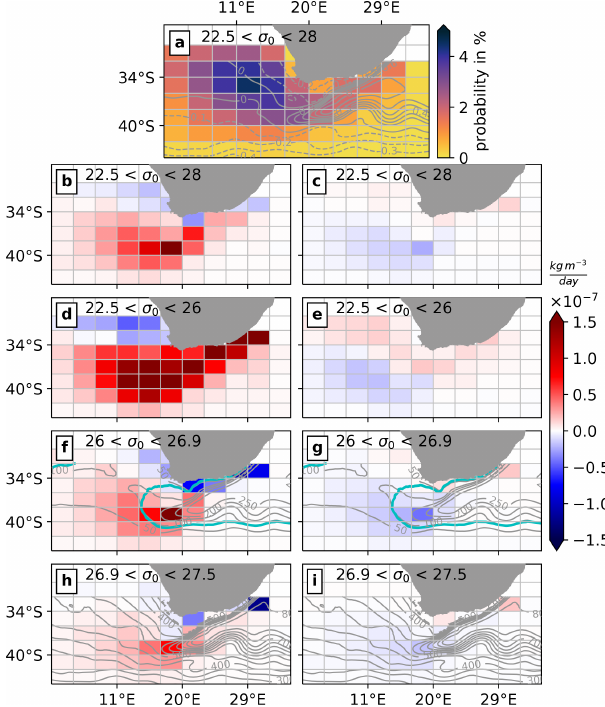
Figure 7. Pathways and horizontal distribution of the density changes of Agulhas leakage for experiment P: (a) relative transport- weighted probability in percent of all Agulhas leakage waters (con- sidering all Agulhas leakage particles per bin at each time step). Contour lines show the mean (1958–2014) sea surface height (in m). Density changes due to the (b, d, f, h) thermal and (c, e, g, i) haline effect for (b, c) all water masses, (d, e) upper waters (22 . 5 < σ 0 < 26), (f, g) central waters (26 < σ 0 < 26 . 9) and (h, i) AAIW (26 . 9 < σ 0 < 27 . 5). To assign waters to these water masses, σ 0 in the Agulhas Current at 32 ◦ S is used. The bin size of all his- tograms is 2 ◦ in latitude × 3 ◦ in longitude. See Sect. 2.3 for details on the calculation. Grey contour lines in (f, g) and (h, i) show the mean (1958–2014) depth of the σ 0 = 26 and σ 0 = 26 . 9 surfaces, respectively. East of the cyan line the mean (1958–2014) depth of σ 0 = 26 is below the mean (1958–2014) winter (JJA) mixed layer